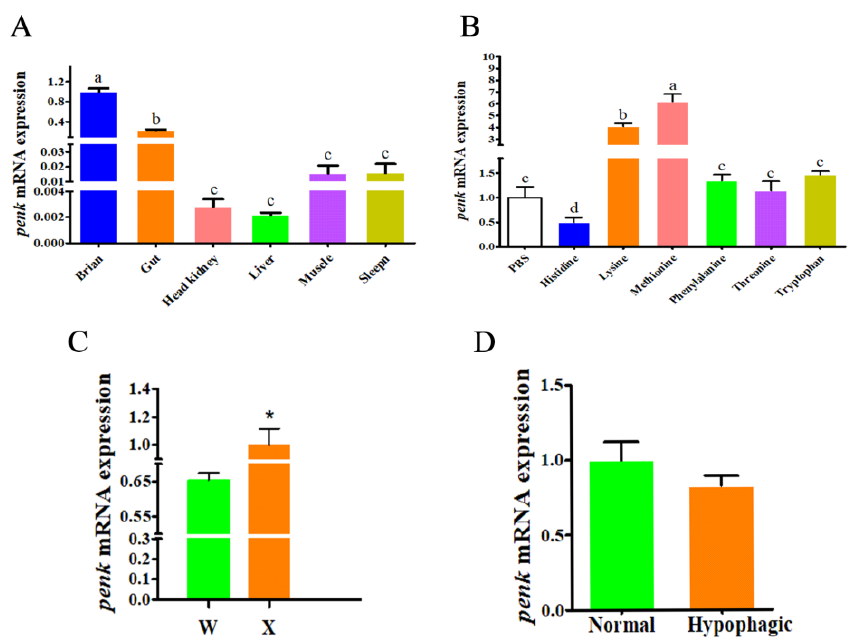
Figure 2. Real-time quantitative RT-PCR detection of various tissues of mandarin fish and brain tissue of mandarin treated by different experiments. ( A ) The expression of penk mRNA in the brain, the gut, the liver, muscles, the spleen, and the head kidney in mandarin fish ( n = 6). The significant level is marked with different letters above the bars ( p < 0.05) compared with the control group. ( B ) Effects of histidine (His), lysine (Lys), methionine (Met), threonine (Thr), tryptophan (Try), and phenylalanine (Phe) on the expression of penk mRNA in the brain ( n = 6). Significance levels are marked with different letters above the bar graph ( p < 0.05). ( C ) The expression of penk mRNA in the brain regions with different domestication abilities from group W and group X ( n = 6). The significant level is marked with an asterisk. ( D ) The expression of penk mRNA in the brain regions from the normal group and the hypophagic group ( n = 6). The significant level is marked with an asterisk.